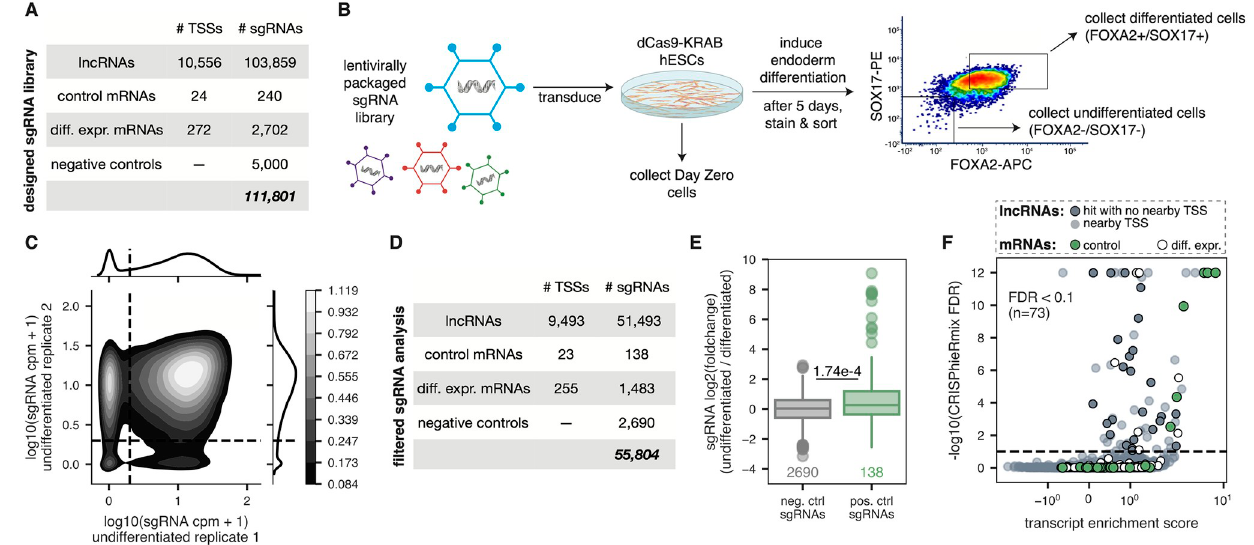
Fig 3. CRISPRi screen identifies lncRNA loci that reproducibly affect endoderm differentiation. (A) Number of TSSs targeted and corresponding unique sgRNAs in the CRISPRi library. (B) Schematic overview of the CRISPRi screen. The sgRNA library was packaged into lentivirus and transduced into dCas9-KRAB-GFP hESCs, which were then induced to undergo endoderm differentiation. Day Zero cells were collected to measure initial representation of the sgRNA library. After five days, the cells were sorted for endoderm markers SOX17 and FOXA2, and populations of differentiated and undifferentiated cells were collected, as shown in the representative FACS plot. PE = phycoerythrin. APC = allophycocyanin. (C) Kernel density estimate plot showing the counts per million in the undifferentiated populations for both replicate 1 and replicate 2. Horizontal and vertical lines define a cpm of 1 in each replicate; color bar indicates densities of sgRNAs. (D) Number of TSSs targeted and corresponding unique sgRNAs after filtering steps that are used in downstream analyses. (E) Distribution of sgRNA enrichments (DESeq2 log2 fold-change of undifferentiated counts compared to differentiated counts, including a batch term) for scrambled negative control sgRNAs (gray) and positive control targeting sgRNAs (green). P-value shown is from a one-sided Mann Whitney test. (F) Plot showing the transcript enrichment score (average DESeq2 log2 fold-change of top 3 most enriched sgRNAs) and CRISPhieRmix global FDR values for each lncRNA transcript (gray), positive control transcript (green), and differentially expressed mRNA transcript (white) tested. Hit lncRNA transcripts that do not have another gene TSS within 1000 bp of their own TSS are further highlighted (dark gray). Horizontal line defines an FDR cut-off of